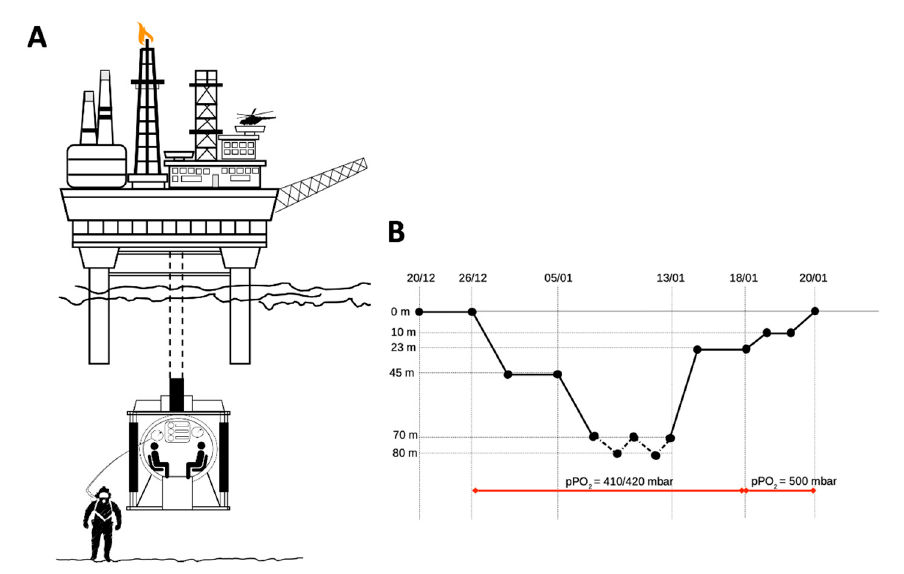
Figure 1. Experimental study design. In ( A ) the accommodation chamber; ( B ) diving profile: divers were onboard from 20 to 26 December, then were compressed to 45 m and worked there until 5 January. Then they were compressed to 70 m and worked between 70 and 80 m for about 8 days. Finally, divers were progressively decompressed to surface (with a brief stop at 23 m for potential supplemental work at that depth, not performed).